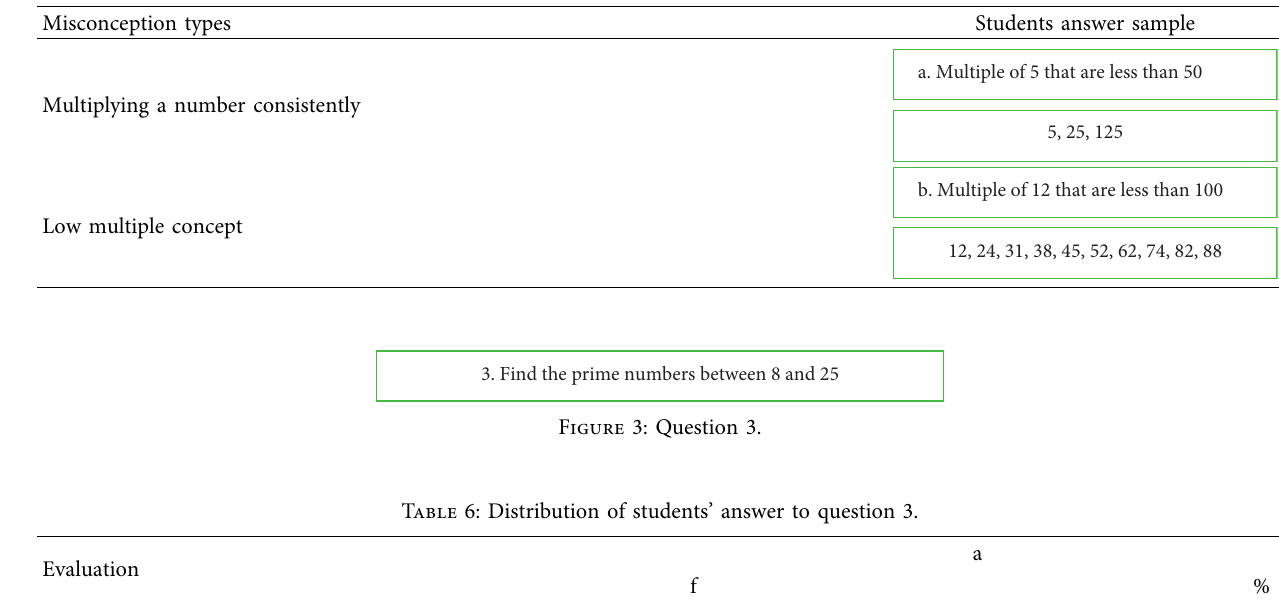
Table 5: Students misconception in question 2 and examples of students’ answer.